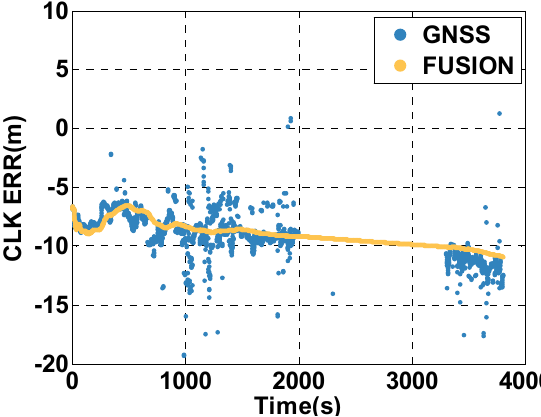
Figure 17. Clock error estimated by the MTF method and by GNSS alone.